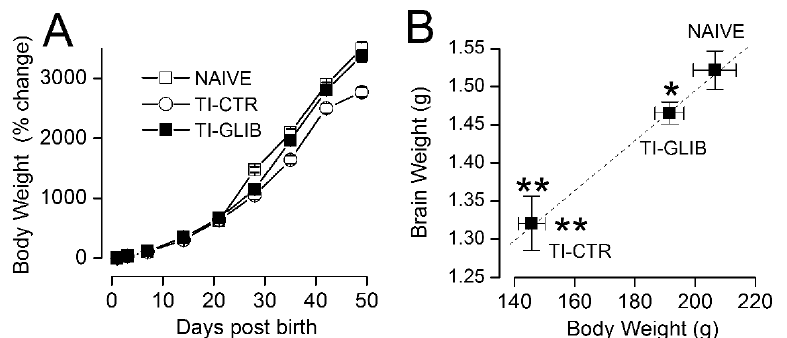
tandem insults (TI). ( A , B ) Percent gain in body weight (means ± S.E.) as a function of time ( A ), and body weight versus brain weight (means ± S.E.) at P52 ( B ) in pups subjected to no injury (naïve), or in pups subjected to TI whose mother was administered vehicle (TI-CTR), or in pups subjected to TI whose mother was administered low dose glibenclamide infusion after IUI (TI-GLIB); data from 12 naïve, 10 TI-CTR and 22 TI-GLIB pups, respectively; ** p <